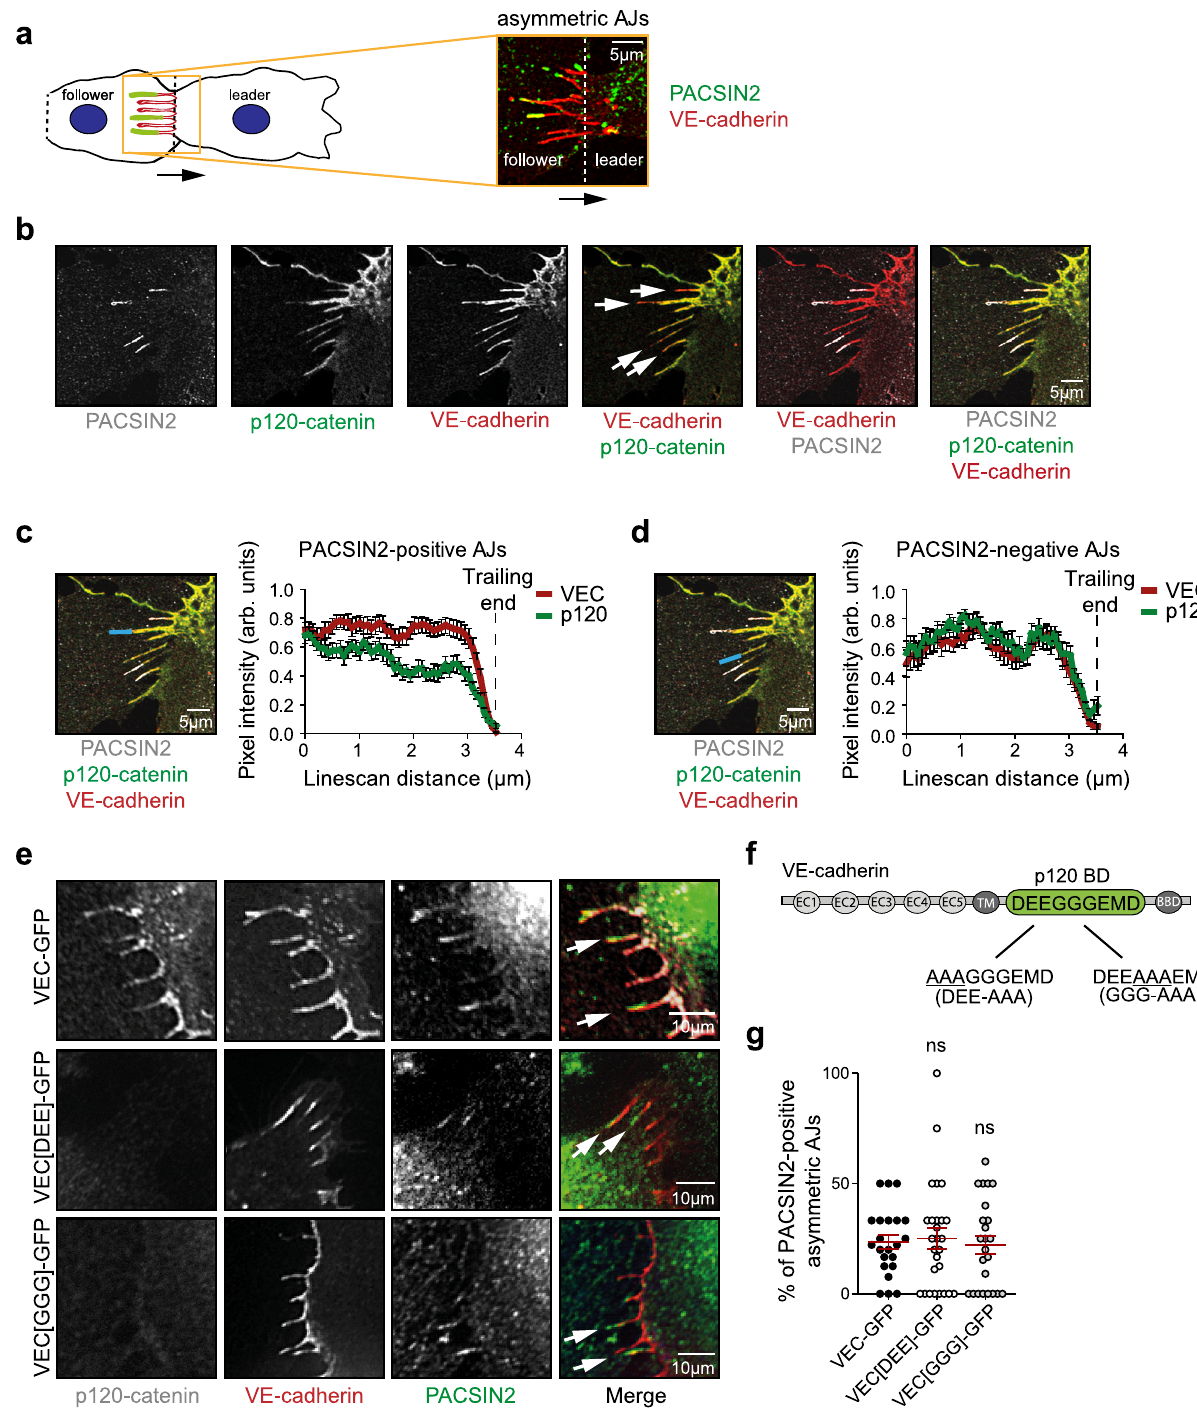
VE-cadherin traf fi cking, we pulse-labeled VE-cadherin molecules